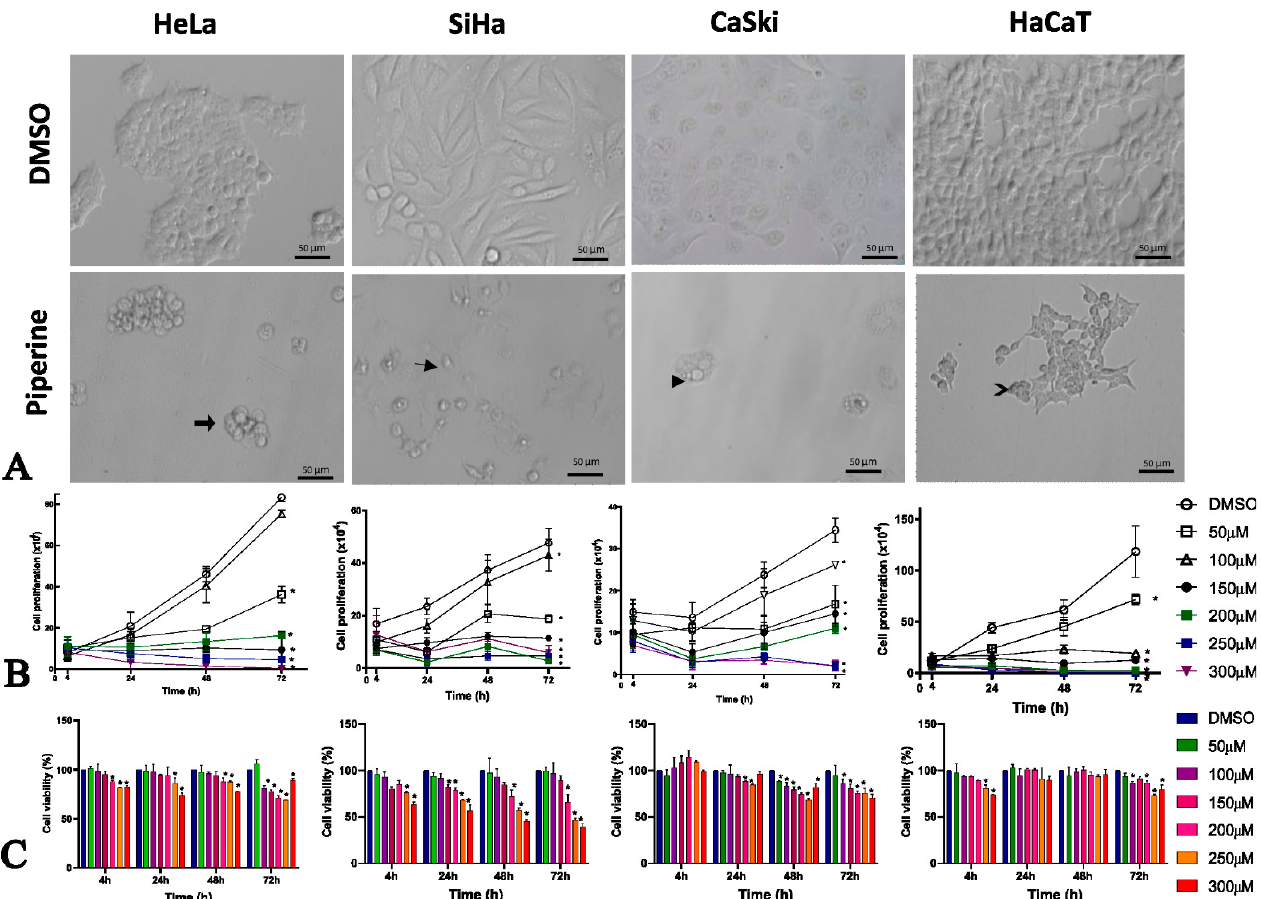
Figure 1. Piperine alters cell morphology, proliferation, and viability. ( A ) Photomicrograph of the morphology of HeLa, SiHa, CaSki, and HaCaT cell lines after 24 h of treatment compared with control (DMSO) and piperine [150 µM]. The thick arrow and chevron arrow point to blebs, the arrowhead indicates intracellular vesicles, and the thin arrow shows membrane disruption. ( B ) Representative graph of cell proliferation after treatment with piperine at concentrations of 50, 100, 150, 200, and 300 µM after, 4, 24, 48 and 72 h of treatment. ( C ) Viability of cells treated with piperine at concentrations of 25, 50, 100, 150, 200, 250, and 300 µM and after 24, 48, and 72 h of treatment. * vs. control, p < 0.05.